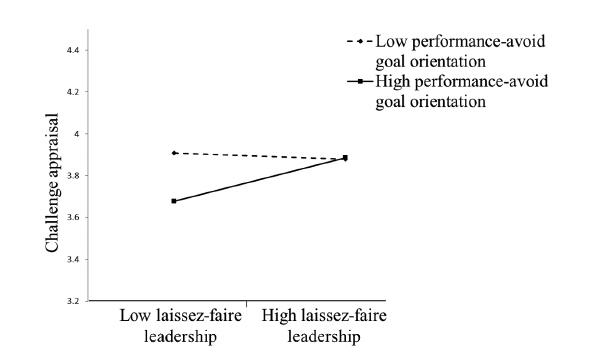
FIGURE 4 Performance-avoid goal orientation moderates the relationship between laissez-faire leadership and challenge